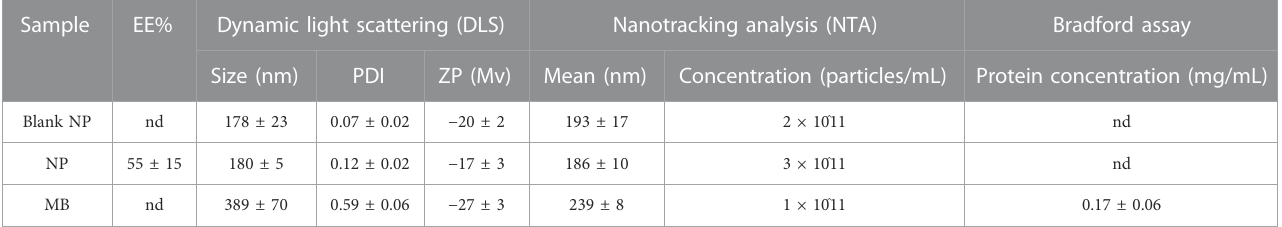
TABLE 2 Physicochemical aspects of developed blank NP, NP, and isolated U251 membrane (MB). Size, PDI, and ZP data from DLS analyses; mean and particle concentrationfromNTAanalyses.Bradfordassaywasperformedtorecordproteincontent.Datarepresenttheaverageofatleast3measurements(n=3)andstandard